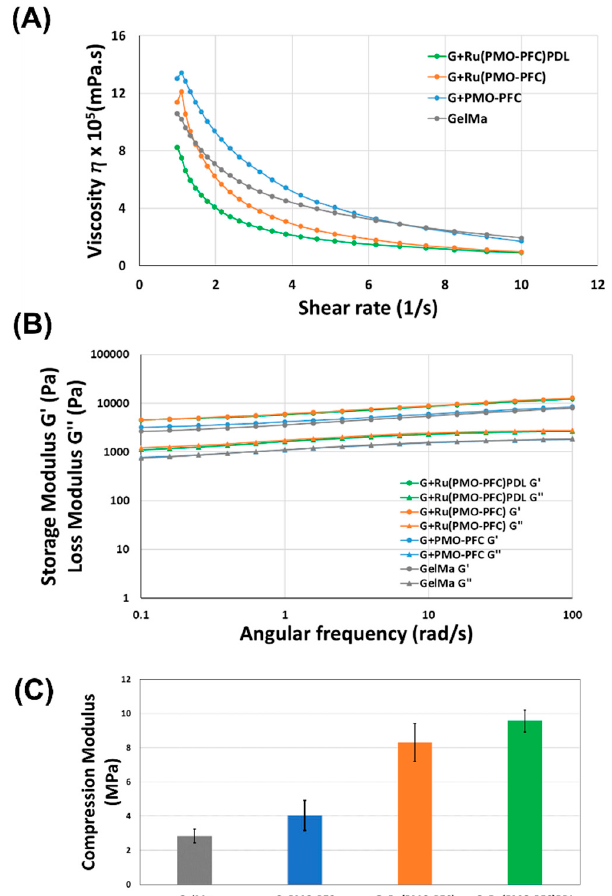
Figure 2. Rheological and mechanical properties of NC hydrogels. Viscosity vs shear rate ( A ), the storage modulus is shown by circle and loss modulus by triangle marker vs angular frequency ( B ), and compression modulus for each hydrogel scaffold ( C ).